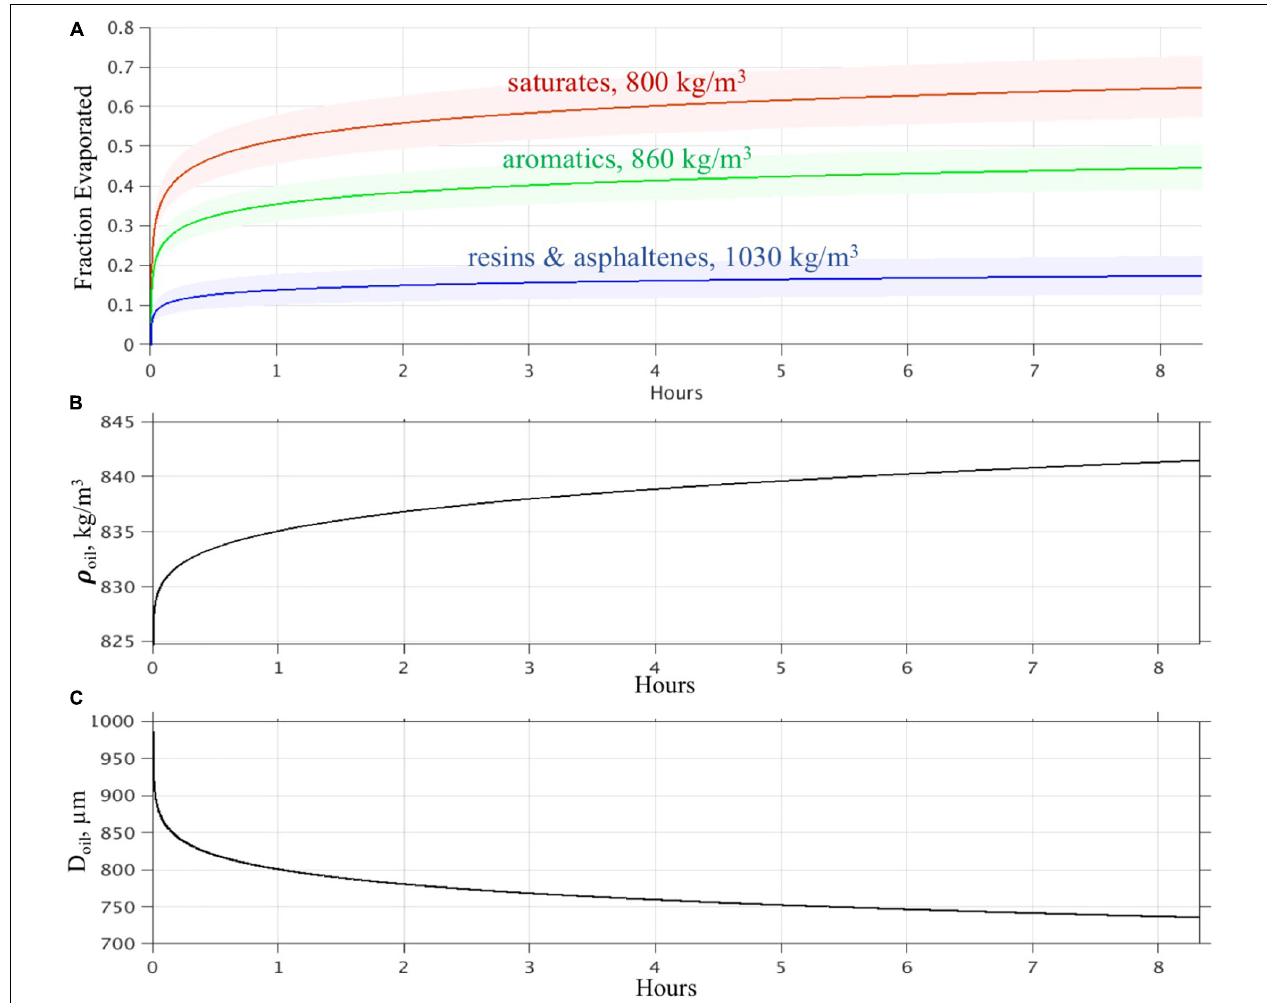
FIGURE 4 | (A) Evaporation curves for saturates, aromatics, and heavy oil compounds calculated using the approach discussed in section “Surface Evaporation of Oil.” The densities of the compounds are listed in the figure. The solid lines are the evaporation curves for 25 ◦ C. The shades highlight the range of the evaporation curves calculated for temperatures from 15 to 35 ◦ C for each compound. The horizontal axis is hours. (B) Change of the oil droplet density due to evaporation. (C) Change of the oil droplet size due to